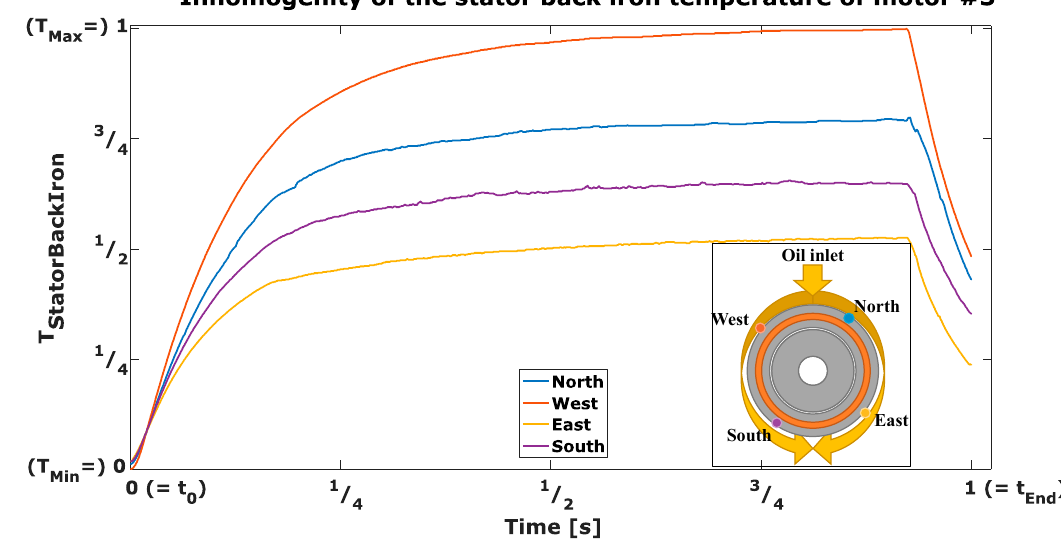
Figure 7. Inhomogeneity of the stator back iron temperature of motor #5.